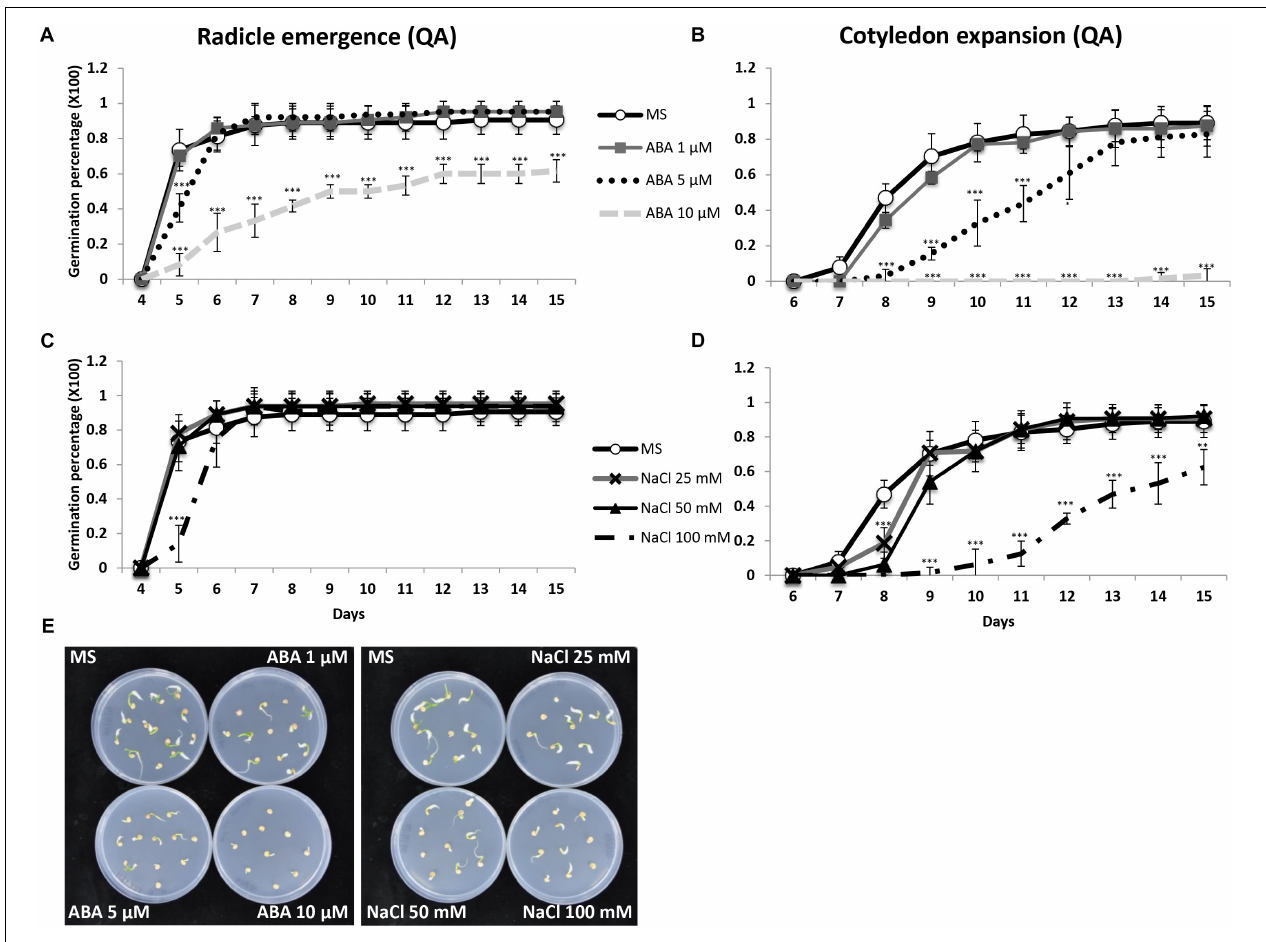
FIGURE 1 | Daily germination percentage in terms of radicle emergence (A,C) and cotyledon expansion (B,D) of QA seeds treated with different concentrations of ABA or NaCl. (E) QA seeds incubated (day 8) on control medium and media with different concentrations of ABA (1, 5, 10 µ M) or NaCl (25, 50, 100 mM). Values indicate mean ± SD ( n = 50). Asterisks represent significance levels using Student t -test; ∗ P ≤ 0.05; ∗∗ P ≤ 0.01; ∗∗∗ P ≤ 0.005. QA, Quadrato D’Asti